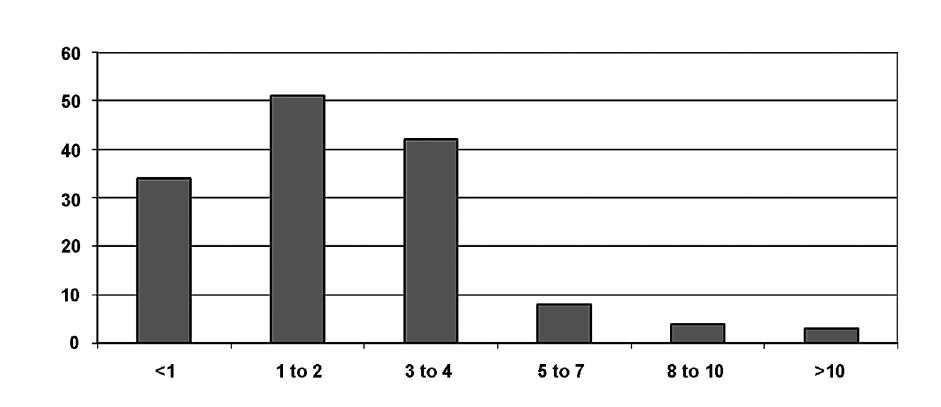
Figure 3 – Difficult urethral catheterization cases that responding residents dealt with in a